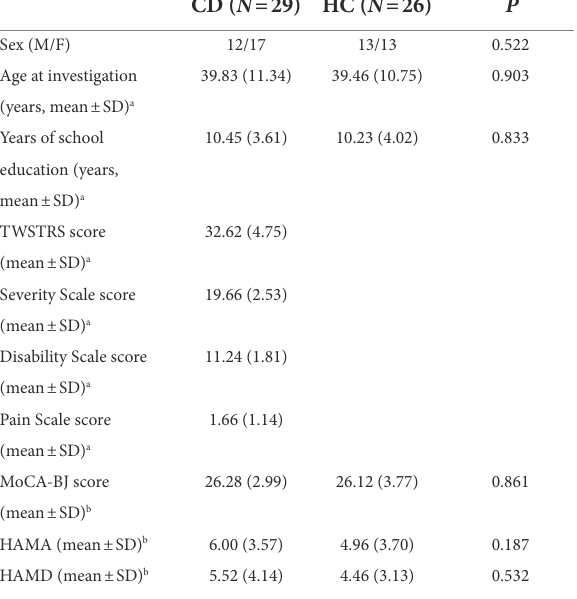
TABLE 1 Demographic data and neuropsychological background data of the CD and HC